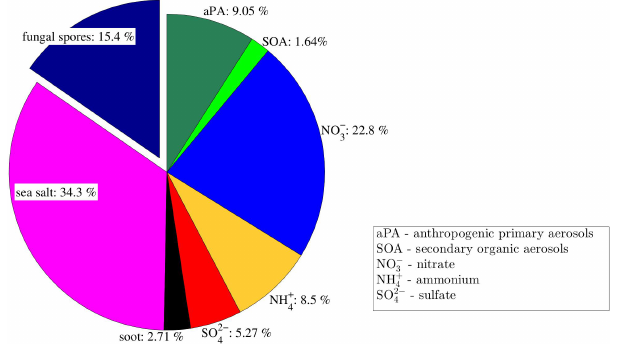
Figure 11. Near-surface chemical aerosol mass composition sim- ulated by COSMO-ART, horizontally averaged over the land area in the model domain and temporally averaged from 26 August to 1 September 2010 (excluding a spin-up period of